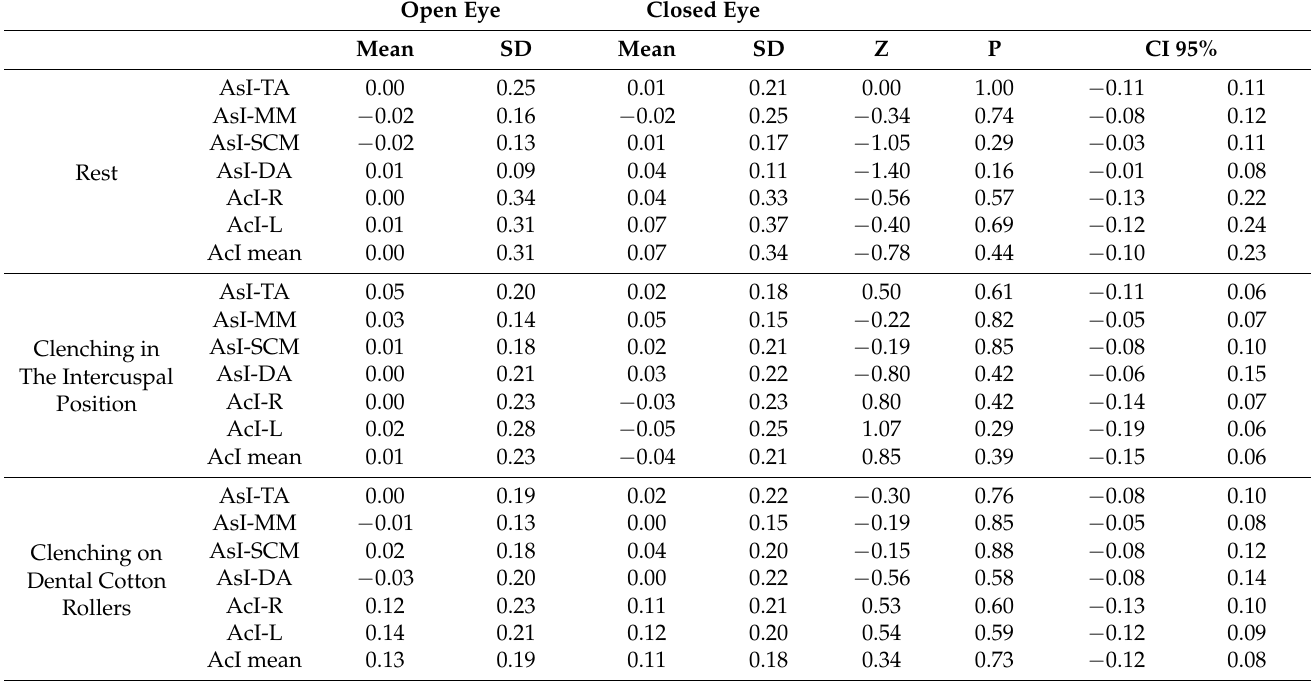
Figure 2. Graphical representation of bioelectrical activity of selected muscles of the masticatory and cervical spine muscles in women. TA—the anterior part of the temporalis muscle; MM—the superficial part of the masseter muscle; SCM—the middle part of the sternocleidomastoid muscle; DA—the anterior belly of the digastric muscle; R—right site; L—left site. Table 3. Results of the comparison of bioelectrical patterns of selected muscles of the masticatory and cervical spine muscles in women. Statistical analysis of AcI and AsI patterns conducted on the women’s group showed no significant statistical differences in the tested muscle activities of TA, MM, SCM, DA Open Eye Closed between the tests Table 3 and Figure 3.